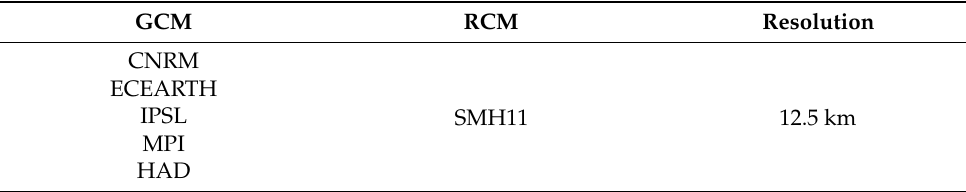
Table 2. EURO-CORDEX simulations applied in this